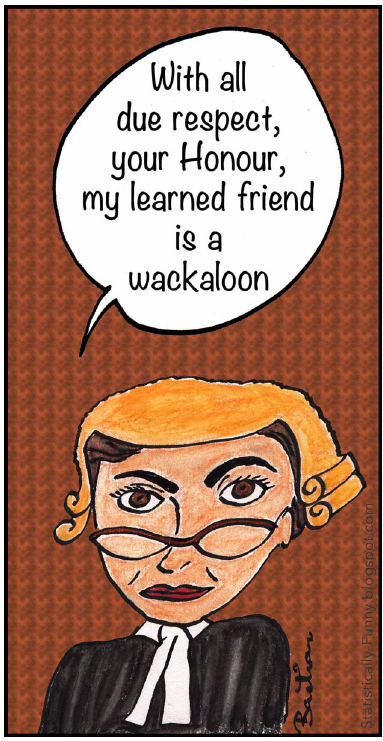
Figure 1. The melding of Internet culture and traditional communication.